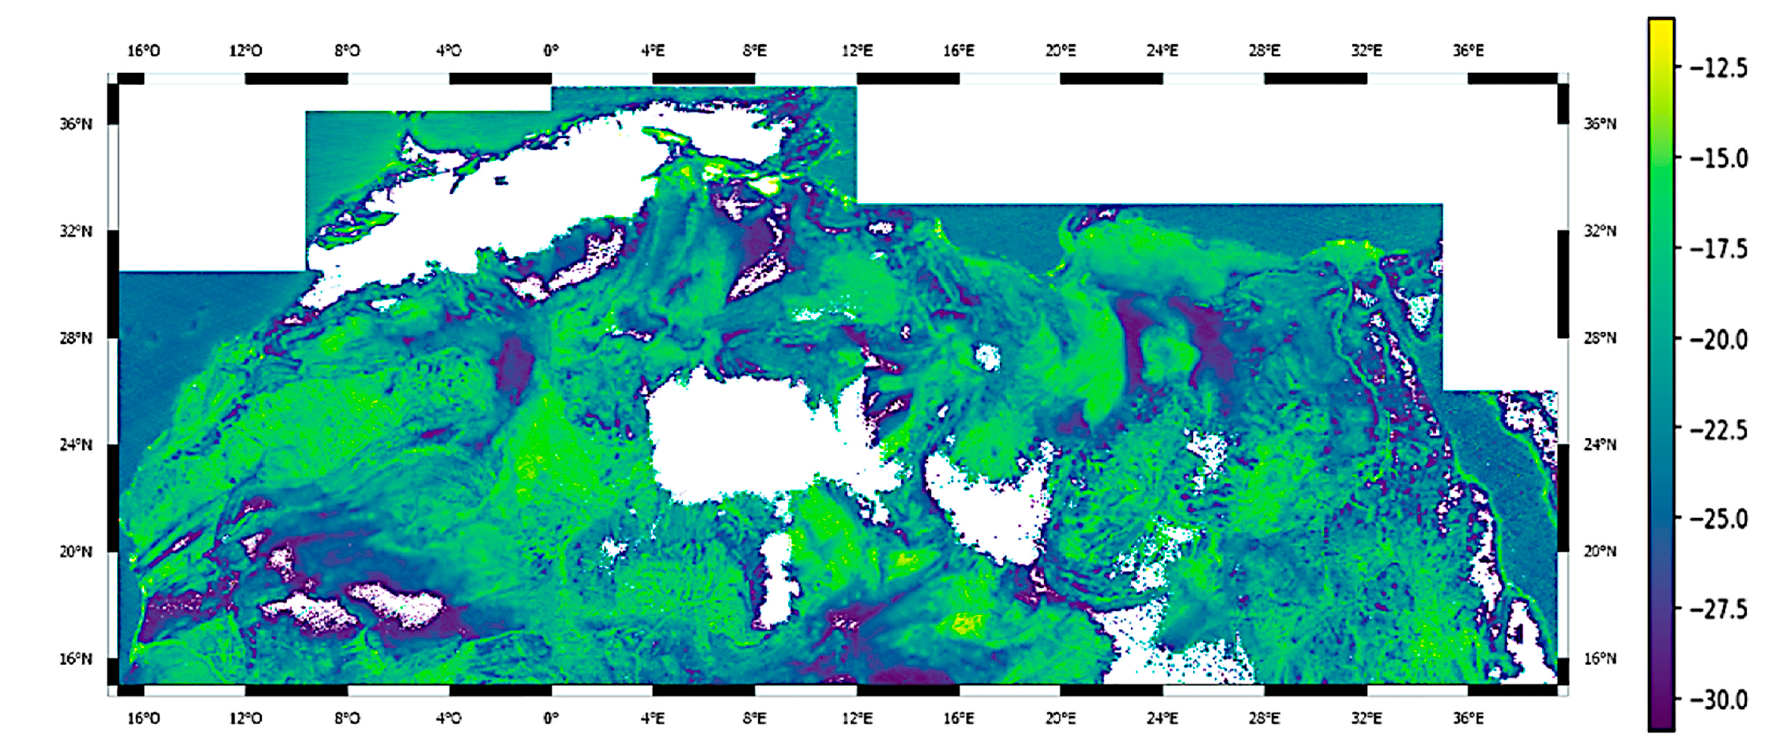
Figure 5. Average reflectivity (dB) map (mosaic) of the Sahara region, with a gridded-pixel size of 0.03° × 0.03°. Mountains and areas with low received signals are masked (white color).